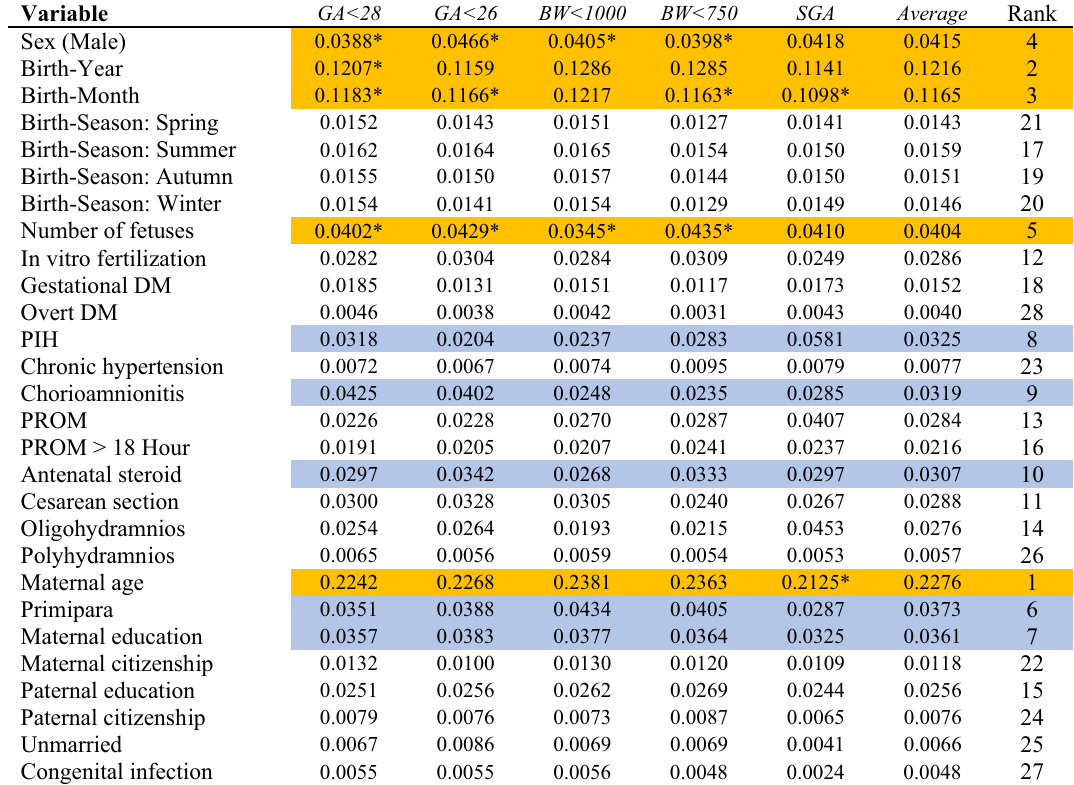
Table 4. Random forest variable importance for adverse birth outcomes: PM 10 excluded. The ranking of a top-5 predictor was highlighted with the color of orange and 6–10 predictor was highlighted with the color of mild blue. BW, birth weight (grams); DM, diabetes mellitus; GA, gestational age (weeks); PIH, pregnancy-induced hypertension; PM, particulate matter; PROM, prelabor rupture of membranes; SGA, small-for-gestational age. * P < 0.10 chi-square or T Test (Table